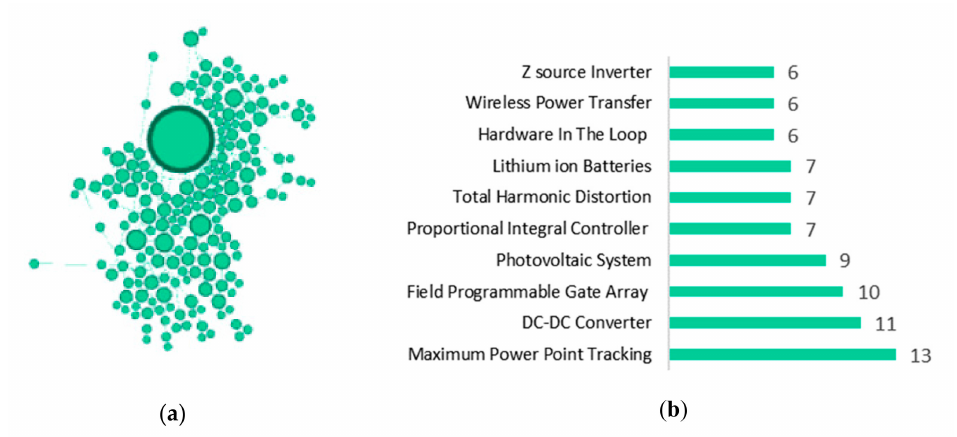
Figure 11. Representation of the Power Electronics community: ( a ) Isolated distribution of